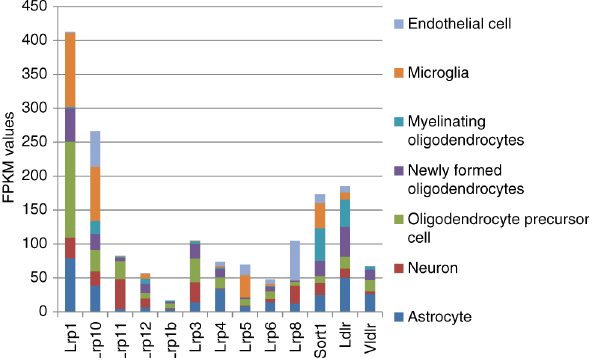
Figure 3: FKPM values of Lrp receptors in 7 brain cell types (1). The highest expressed Lrp receptor genes in brain cell types are Lrp1 , Lrp10 , and Sort1 [4]. Lrp11 manifests a neuron cell-specific receptor preference. Lrp8 is a largely endothelial cell-specific